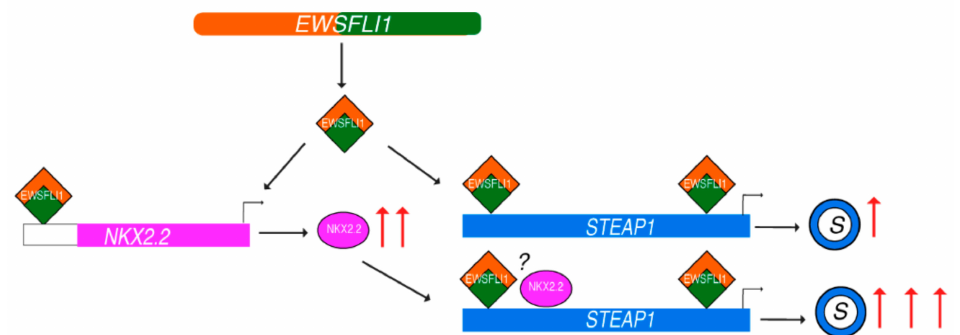
Figure 8. Model representing STEAP1 regulation by NKX2.2 and EWSFLI1: Formation of EWSFLI1 translocation generates EWSFLI1 fusion protein that binds to STEAP1 promoter and leads to a moderate increase in its expression. EWSFLI1 also leads to upregulation of NKX2.2 by binding to yet unknown enhancer regions. High concentration of NKX2.2 in the cell results in its binding to STEAP1 promoter in proximity to the EWSFLI1. This binding leads to a significant upregulation of STEAP1 (illustrated as a ring with blue outline), which in turn activates reactive oxygen species, and downstream genes contributing to the proliferative and invasive phenotypes of Ewing’s sarcoma. The question mark indicates the unknown nature of interaction between EWSFLI1 and NKX2.2.